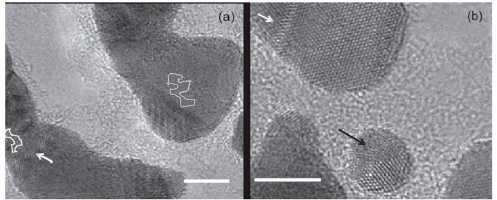
Figure 16. Coalesced Au clusters corresponding to the deposition of 2.12 nm Au on graphene. ( a ) shows variations in thickness and relative crystallographic orientations and ( b ) planar faults such as stacking faults (white arrows) and twin boundaries (black arrow). Scale bars: 5 nm. Reproduced from Reference [66] with permission from Wiley.